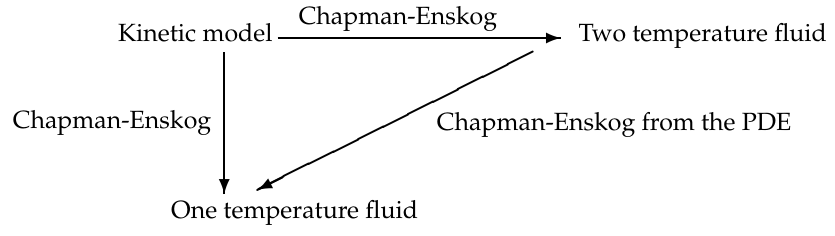
Figure 4. Schematic diagram of the double Chapman–Enskog